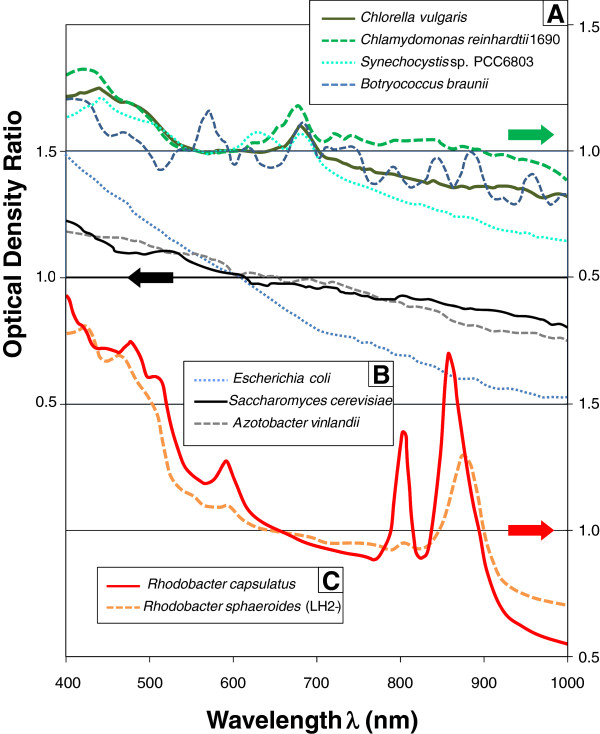
Demonstration of the variation in absorption spectrum among diverse microorganisms. Absorption spectra of a wide variety of microorganisms, obtained on a Spectramax photometer measured at ODR ~1 are grouped as follows: A) Spectra of green photosyntyetic cultures normalized to an OD550 of 1.0, B) Spectra of un-pigmented cultures normalized to an OD600 of 1.0, C) Spectra of red cultures were normalized to an OD660 of 1.0.